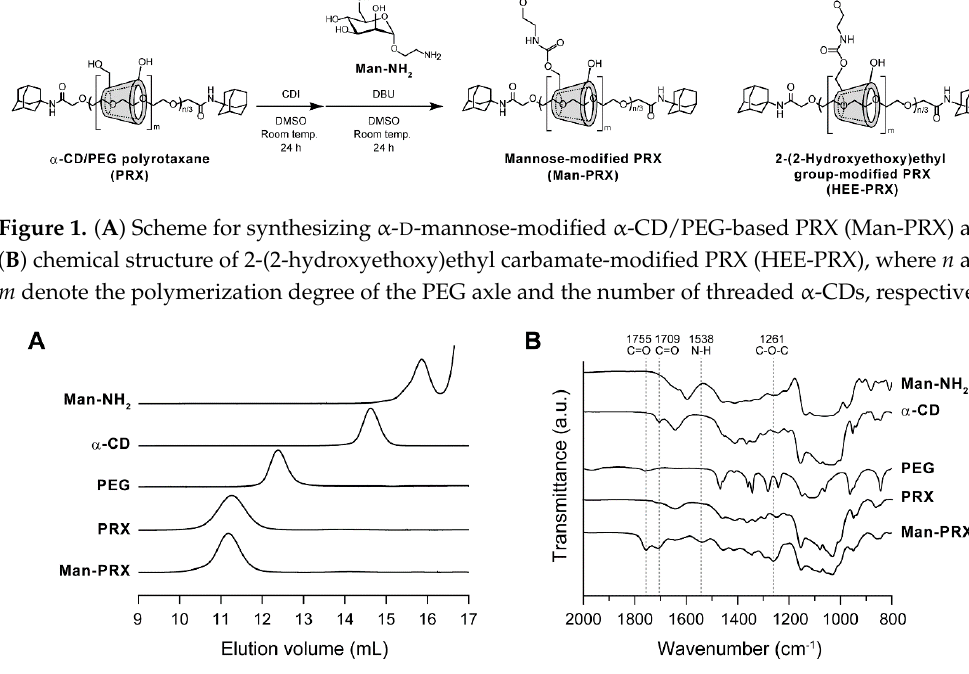
Figure 1. ( A ) Scheme for synthesizing α - D -mannose-modified α -CD/PEG-based PRX (Man-PRX) and ( B ) chemical structure of 2-(2-hydroxyethoxy)ethyl carbamate-modified PRX (HEE-PRX), where n and m denote the polymerization degree of the PEG axle and the number of threaded α -CDs, respectively.